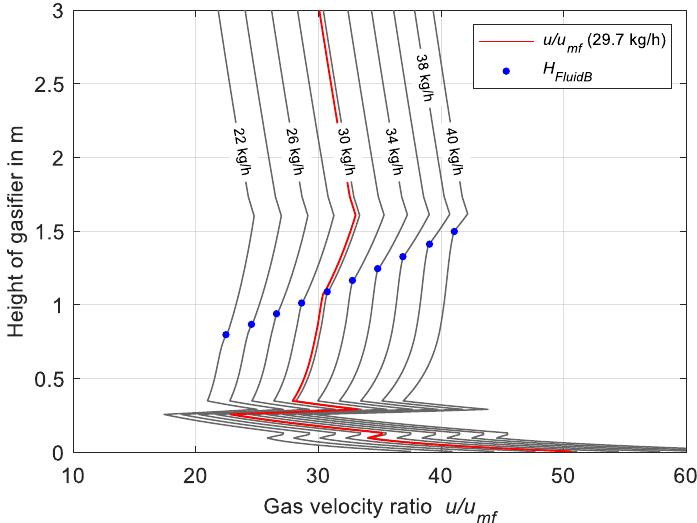
Figure 11. Simulated effect of biomass feeding rate (22–40 kg/h) on gas velocity ratio (superficial gas velocity/minimum fluidization gas velocity) over reactor height and position of bed height ( H FluidB ).